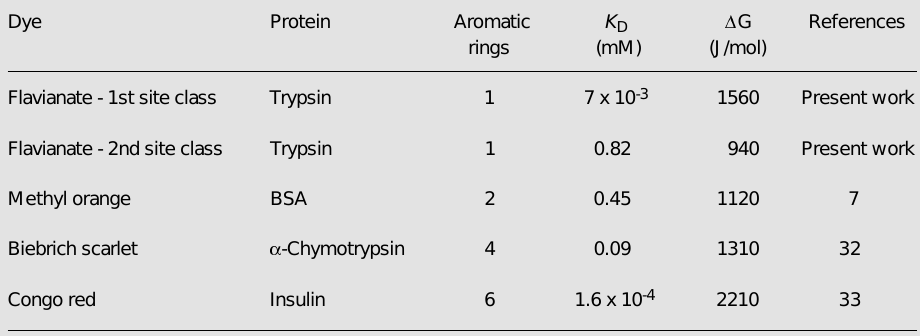
Table 2. Binding parameters found for the interaction of flavianic acid with trypsin at 18 h of incubation, and selected values reported for dye binding to some proteins. Dye